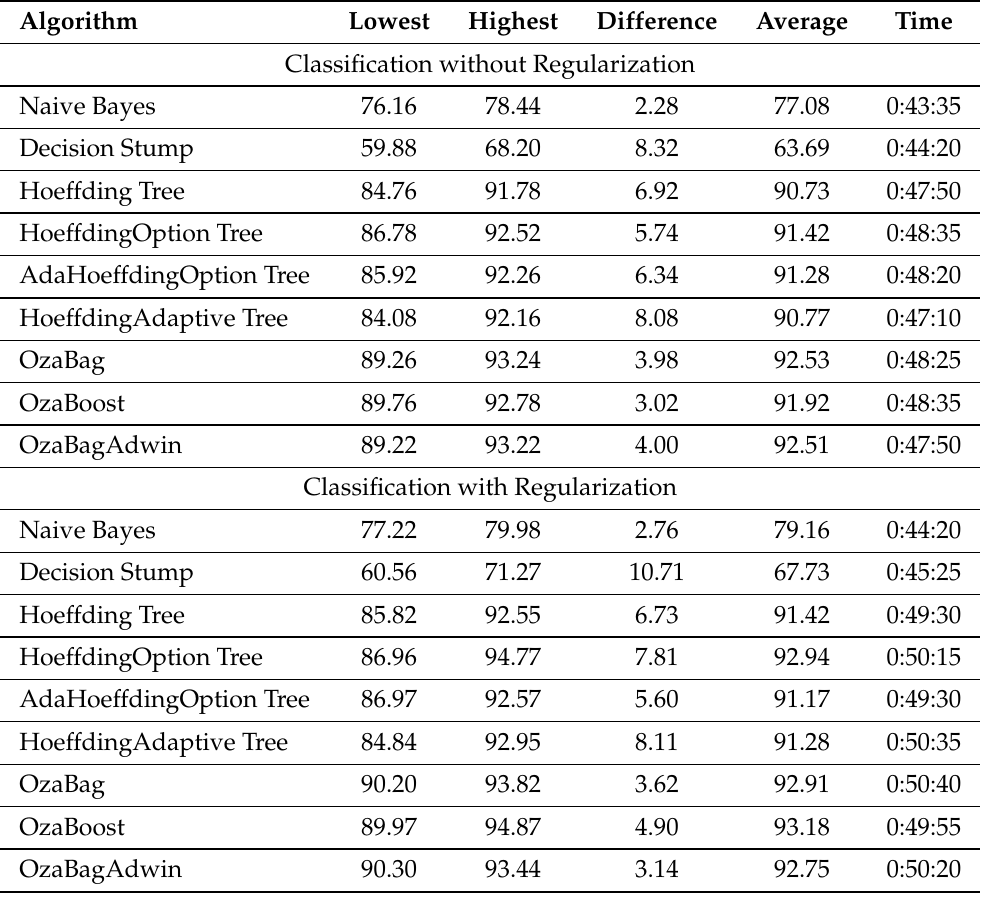
Table 5. Lowest, highest and average accuracy percentages of weather classification for dataset =